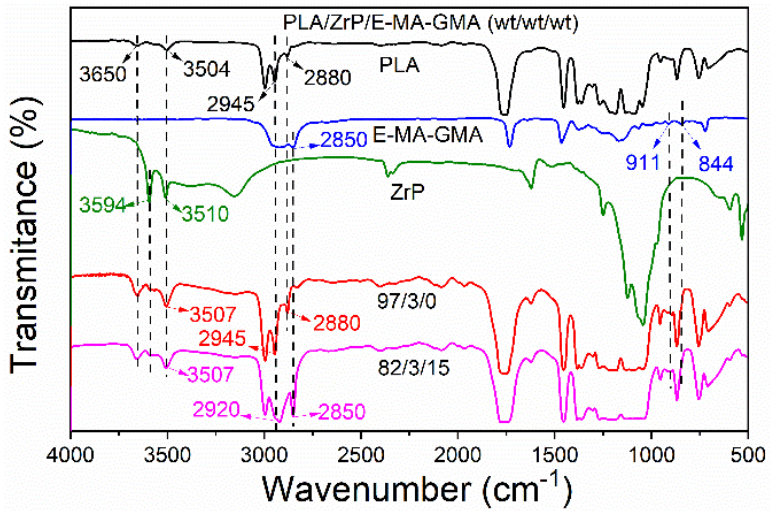
Figure 4. FTIR curves of PLA, E −− MA −− GMA, ZrP, PLA/ZrP and PLA/ZrP/E −− MA −−